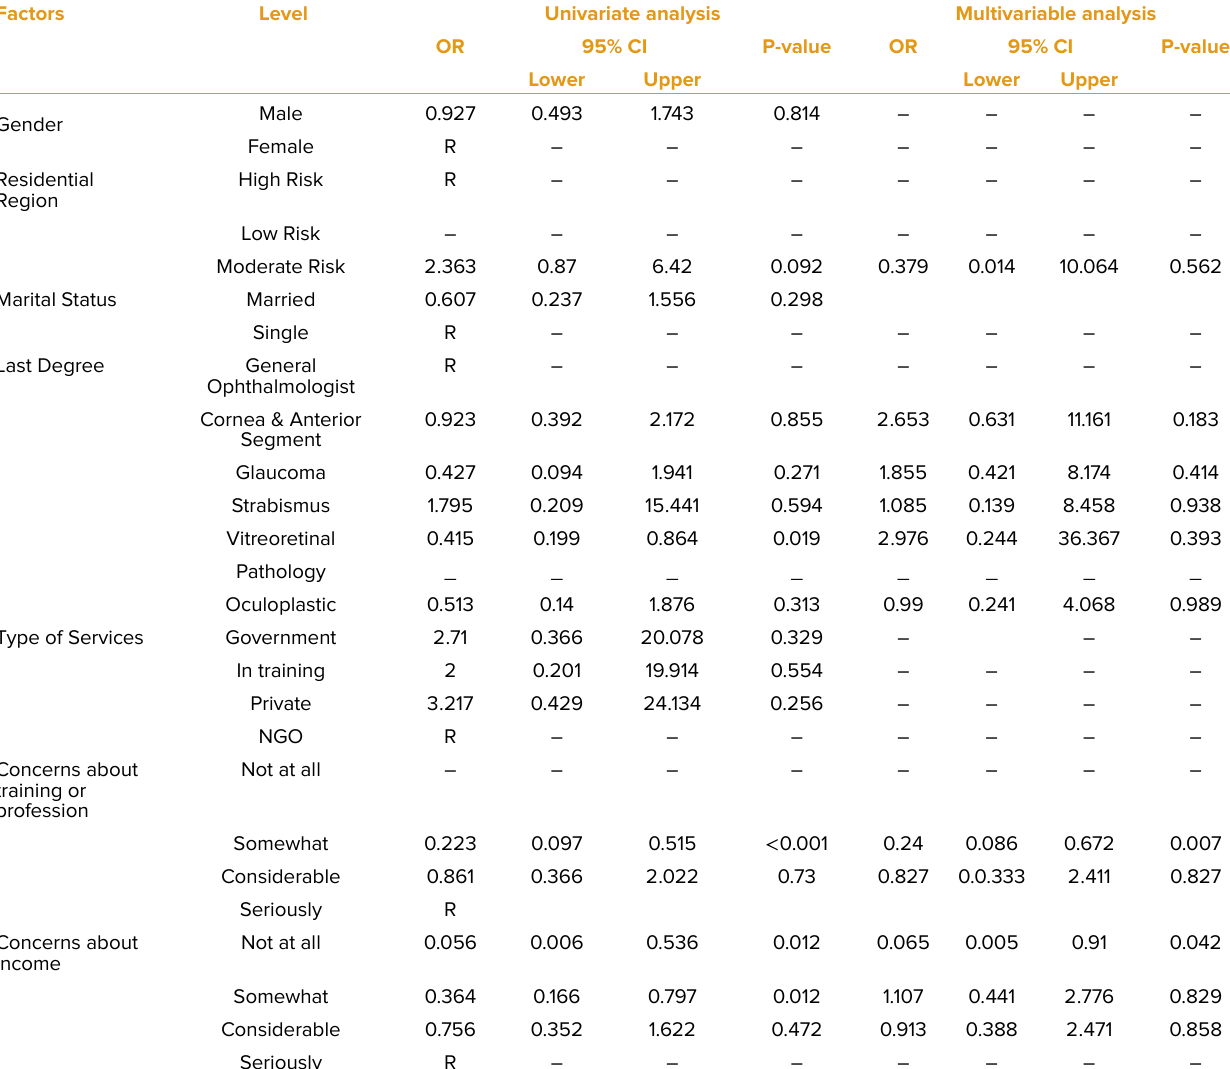
Table 2. Univariate and multivariable analyses of the probable associated factors with depression among ophthalmologists Factors